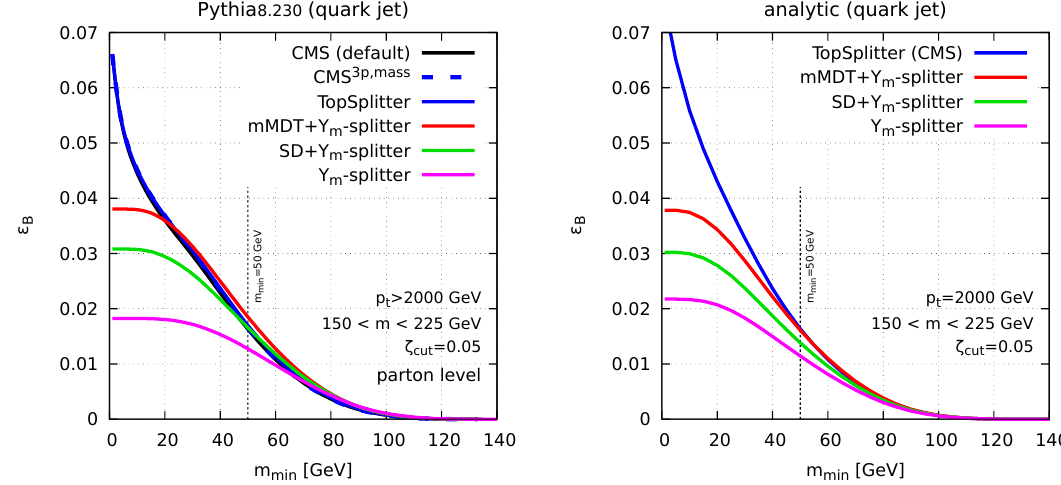
Figure 7. Background e(cid:14)ciency as a function of the m min cut for various taggers. The left plot shows results obtained from Monte Carlo simulations with the Pythia8 generator and the right plot shows the results of our analytic calculations discussed in the main